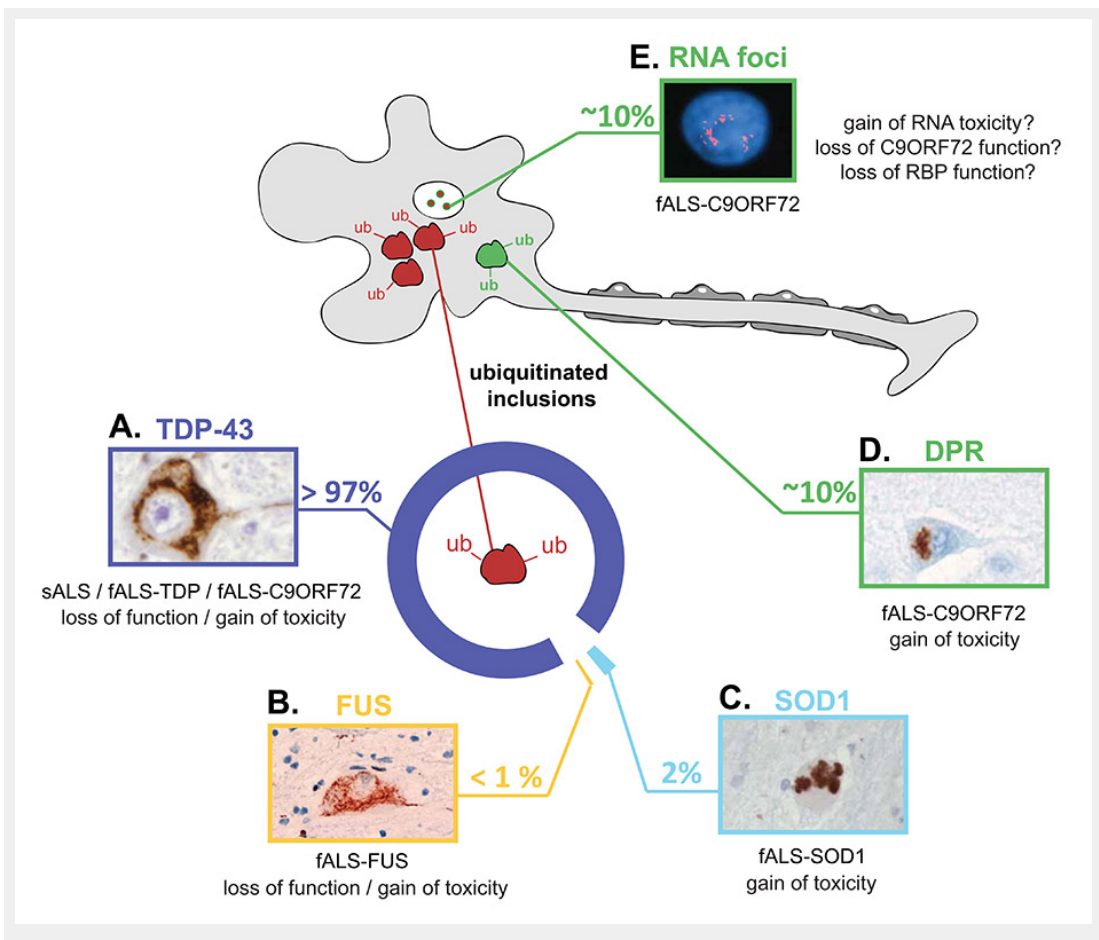
Pathogenic hallmarks of ALS and the underlying factors and mechanisms. The pathologic hallmark of ALS is the presence of ubiquitinated protein inclusions in motor neurons and glial cells primarily of the spinal cord and motor cortex. The major protein component of these inclusions is different in the various types of ALS, highlighting the heterogeneity of the disease. (A) In the majority of ALS cases, including all sporadic and most familial cases, the ubiquitinated inclusions contain TDP-43. When TDP-43 accumulates in the cytoplasm, it is excluded from the nucleus, where it normally resides in healthy cells. These alterations suggest that either loss of normal TDP-43 function or gain of toxicity (or both) may trigger motor neuron dysfunction and death. (B) In 0.5% of fALS that carry mutations in FUS , the cytoplasmic inclusions do not contain TDP-43, but they contain FUS protein. Similar observations to that of TDP-43, with partial nuclear clearance of FUS suggest that its neurotoxity may be the result of either loss of function or gain of toxicity. (C) In fALS patients with SOD1 mutations, misfolded SOD1 accumulates and becomes toxic to neurons. These patients do not contain any TDP-43 or FUS inclusions. (D) In contrast, patients with hexanucleotide repeat expansions in C9ORF72 show typical TDP-43, similar to those found in sALS (A). In addition, C9ORF72 patients accumulate abnormal dipeptide repeat (DPR) proteins, which are produced by an unconventional type of translation of the hexanucleotide repeat RNA, which escapes the nucleus, and binds to ribosomal complexes. In addition to spinal cord motor neurons, DPRs have been observed in the cerebellum, which is typically spared in non-C9ORF72 ALS. (E) In addition to TDP-43 and DPR pathology, C9ORF72 patients accumulate nuclear RNA foci that contain sense and antisense hexanucleotide repeats in neuronal and glial cells. Insert images reproduced with permission from (A) [54], (B) [60], (C) [35], (D) [39], (E)